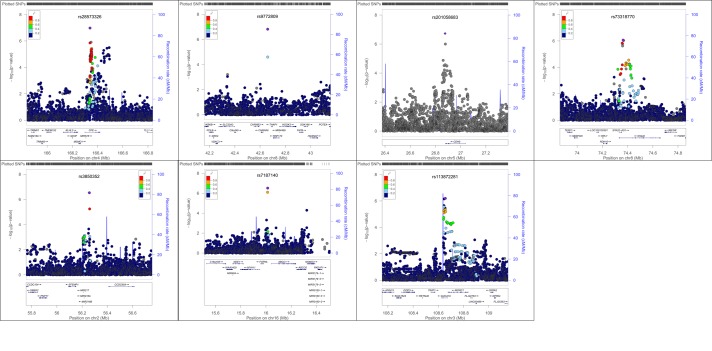
Regional association plots showing–log10(p-values) against base-pair position for African American (AA) women considering grade 0 vs. 1–3 analyses.